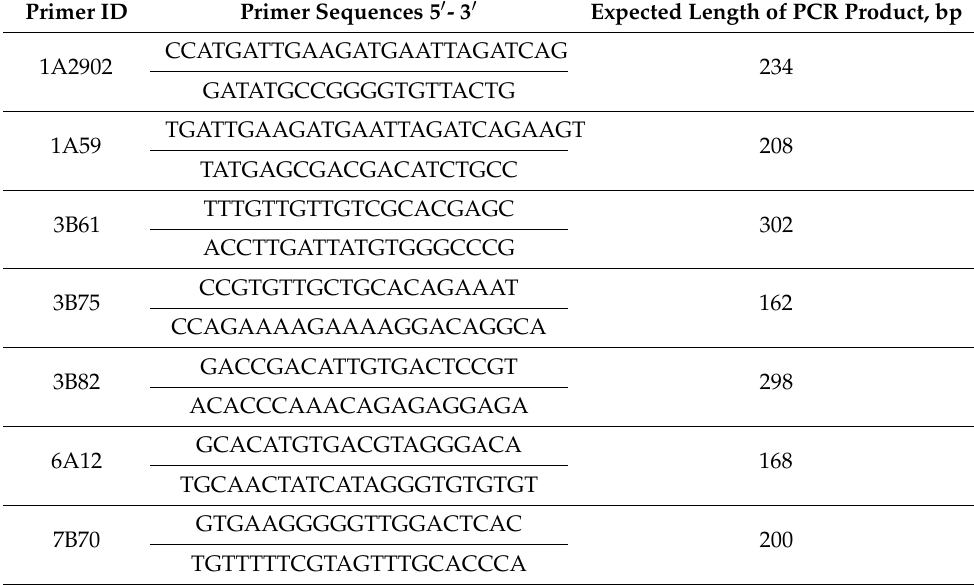
Table 2. Primers used for lncRNA gene polymorphism analysis and the expected length of the PCR